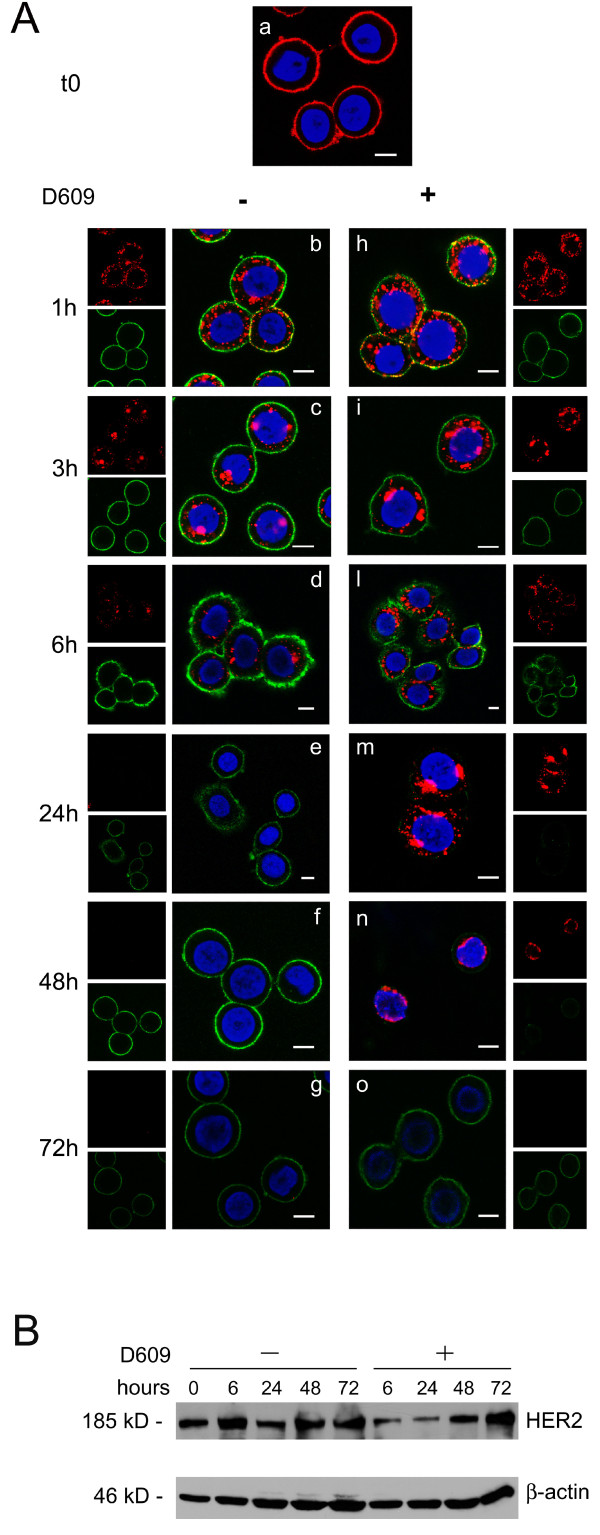
D609-induced retardation of reexpression of HER2 on the plasma membrane of SKBr3 cells after short-term receptor engagement with an anti-HER2 antibody. (a) CLSM examinations on unfixed cells transiently engaged (30 minutes at 4°C) with α-HER2 mAb 300G9, followed by goat α-mouse Alexa Fluor-594 (panel a, red), then cultured at 37°C for the indicated time periods in complete Ab-free medium, either in the absence (b through g) or presence of D609, 50 μg/mL (h through o). At the end of each time interval, cells were stained again on the plasma membrane with the α-HER2 W6/100 mAb, followed by goat α-mouse Alexa Fluor-488 (green). Nuclei were stained with DAPI (blue). Scale bars, 8 μm. These analyses were independently performed 3 times. (b) Western blot analyses of SKBr3 cells first engaged with α-HER2 300G9 mAb, followed by goat α-mouse antibody, and then cultured at 37°C either in the absence or presence of D609 for the indicated time periods. The blots were incubated with α-HER2 or with anti-β actin Abs. These experiments were repeated on seven sets of independent cell preparations.